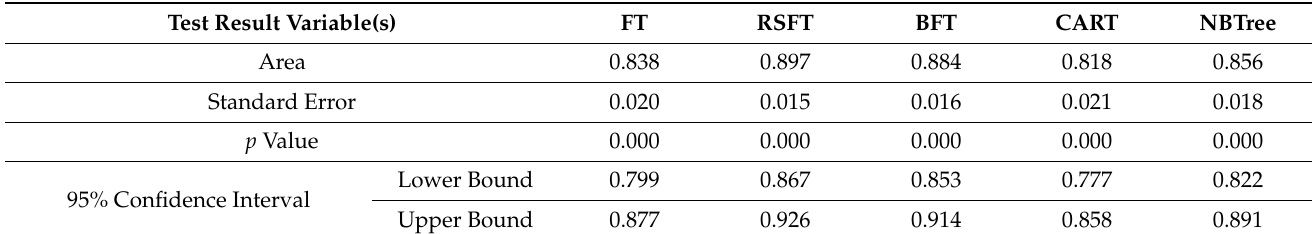
Table 1. Model performance.